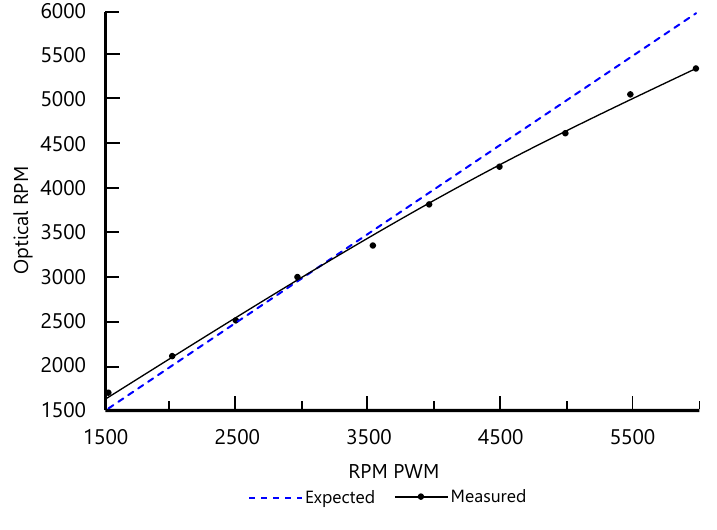
Figure 14. Calculated RPM vs. Measured RPM.